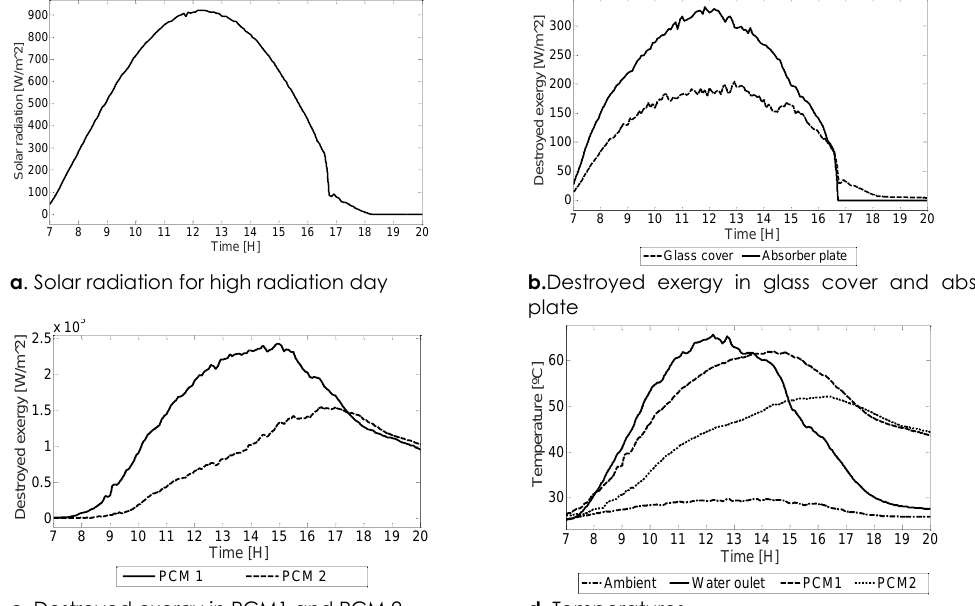
d. Temperatures Figure 6. Results for February 7, 2017: a. Solar radiation, b. Destroyed exergy in glass cover and absorber plate,c. Destroyed